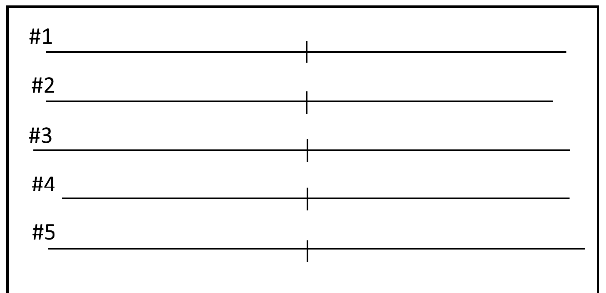
Figure 1. Linelengthjudgementtask. #1. Rt. andLt. segments = 75mm(Equallybisected). #2.Rt. = 70mm; Figure 1. Line length judgement task. #1. Rt. and Lt. segments = 75 mm (Equally bisected). #2. Rt. = 70